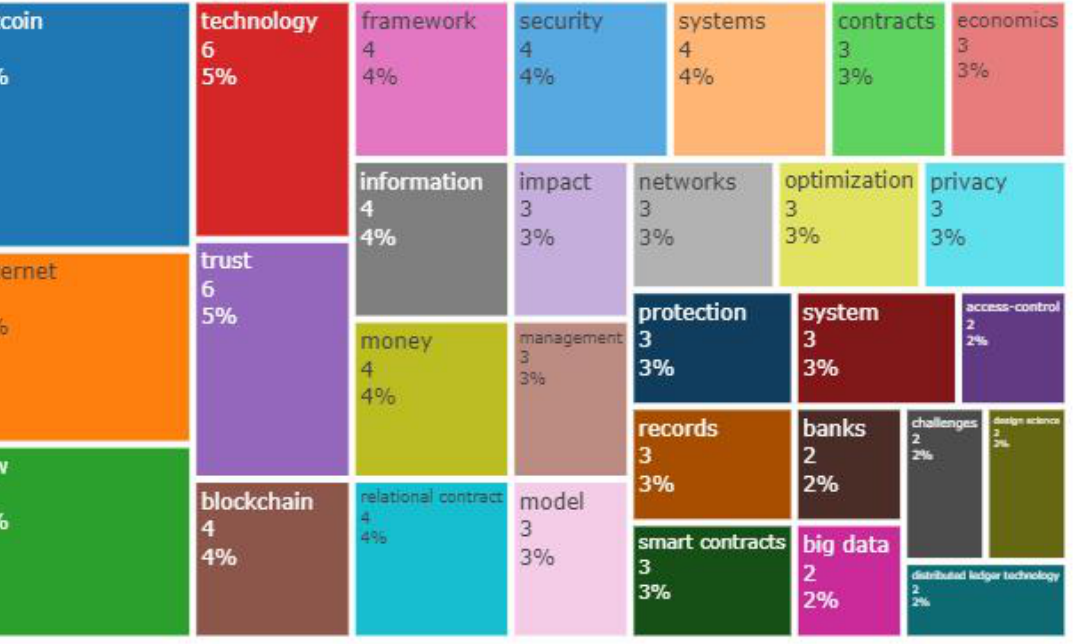
Figure 4. Keyword Plus TreeMap. The number of words (10–30).